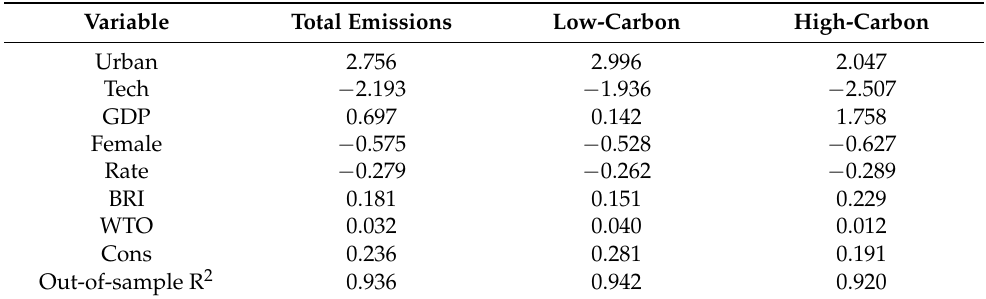
Table 5. The LASSO regression results for total emissions, low- and high-carbon sectors.